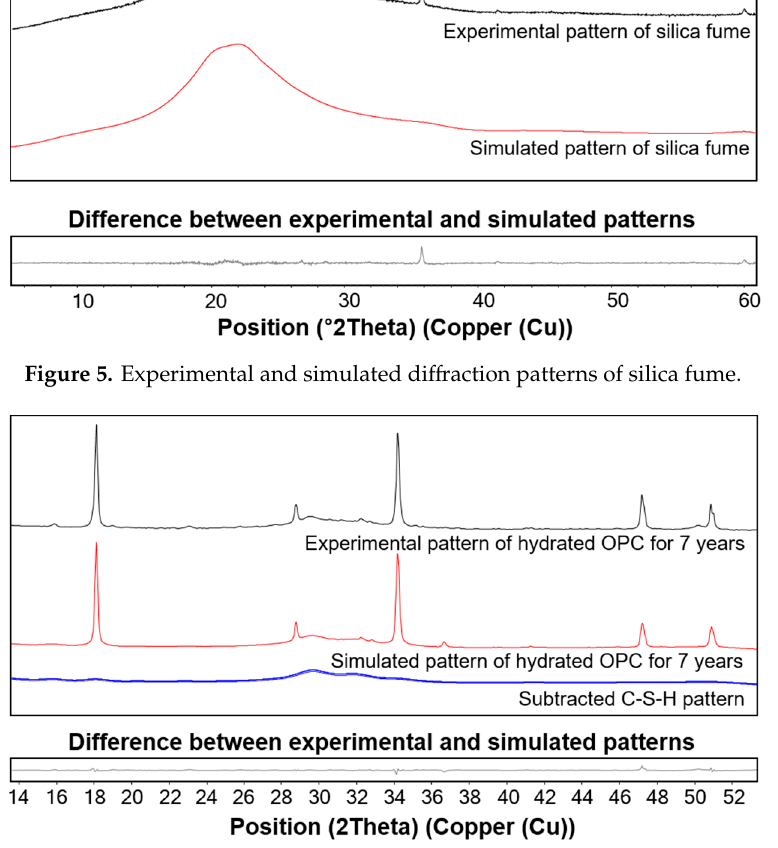
Figure 6. Experimental and simulated di ff raction patterns of C-S-H. The experimental pattern of hydrated OPC for 7 years was reproduced from a previous study [23].